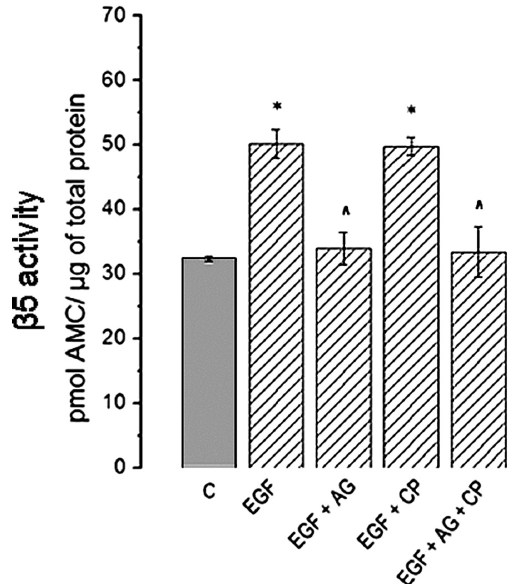
Figure 4. The effect of EGF on the activity of the β 5 catalytic proteasome subunit in DLD-1 colon cancer cells. The activity levels were determined using the fl uoregenic substrate SucLLVY- AMC. Colon cancer cells were fi rst preincubated with AG1478 (1 μΜ ) and CP-724,714 (1 μΜ ) for 30min, followed with the intro- duction of EGF (20 ng/mL). Total incubation time was 48 h. In all the diagrams are presented the p mol of hydrolyzed AMC/the mg of total protein. Statistically signi fi cant differences compared with control or EGF-treated cells are symbolized with * p < 0.05 or ^ p < 0.05,